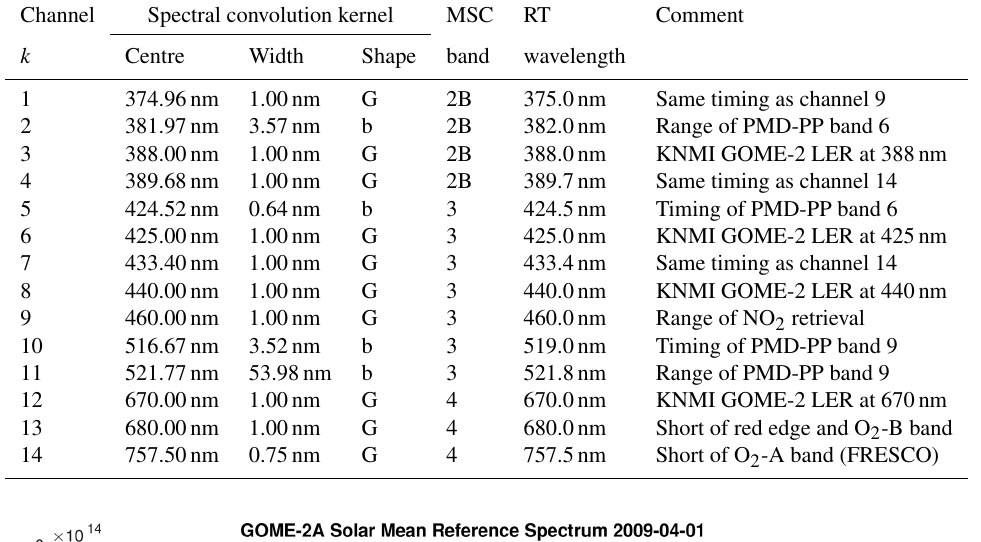
Table 1. Definition of MICRU MSC channels k with spectral convolution kernels K centred at λ and width w . The kernels are either Gaussian (denoted G) or boxcar (denoted b) shaped. According to the spatial aliasing of GOME-2 (Fig. 3), channels 1, 4, 5, and 10 apply the same readout time as corresponding MSC or PMD channels in different bands.